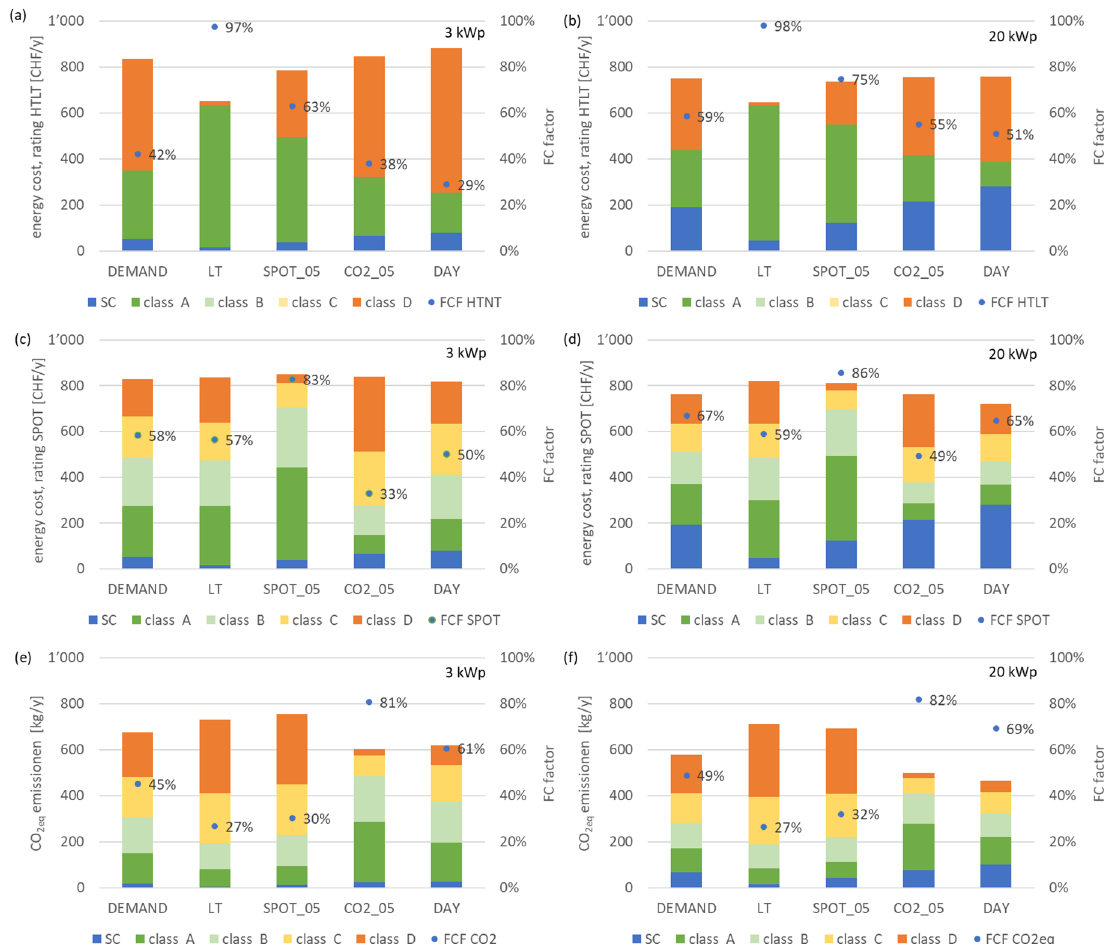
Figure 11. Flexibility classification and FC factors of energy costs (rating HTLT ( a , b ), rating SPOT ( c , d ) and CO 2eq emissions ( e , f ) with photovoltaic system (left: 3 kWp, right 20 kWp).